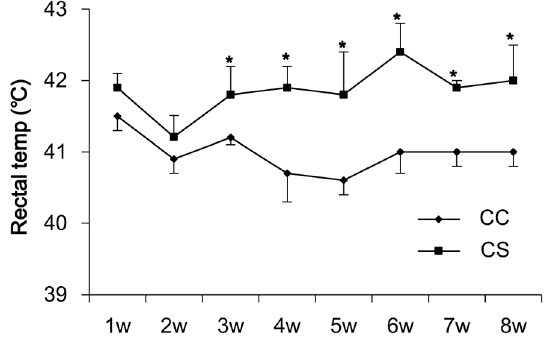
Figure 2. Rectal temperatures of laying broiler breeder chickens in response to the chronic heat challenge at 32 6 C over 8 weeks. In the first week, the rectal temperature of laying broiler breeder chickens in the chronic heat-stressed group (CS) was not elevated by the cyclic environmental temperature (32-35-32 u C) and only a tendency of increase in rectal temperature was observed in the second week. After exposed to the consistent 32 u C thermal treatment from the third week, CS birds had a significantly higher average body temperature than those in the chronic control group (CC). Values are expressed as means 6 SE of data from 10–12 individual birds. * indicates significant differences (P , 0.05) between CS (line with squares) and CC (line with diamonds) at the same time of the trial.